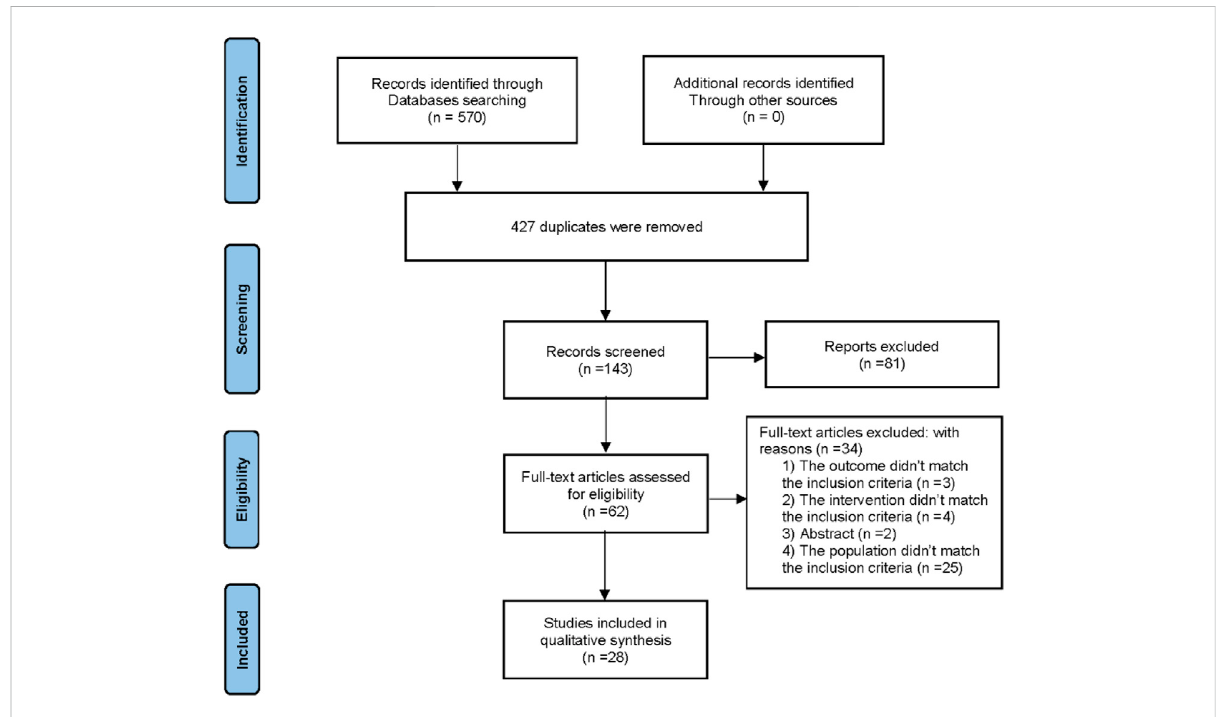
FIGURE 1 Flow diagram depicting the study screening